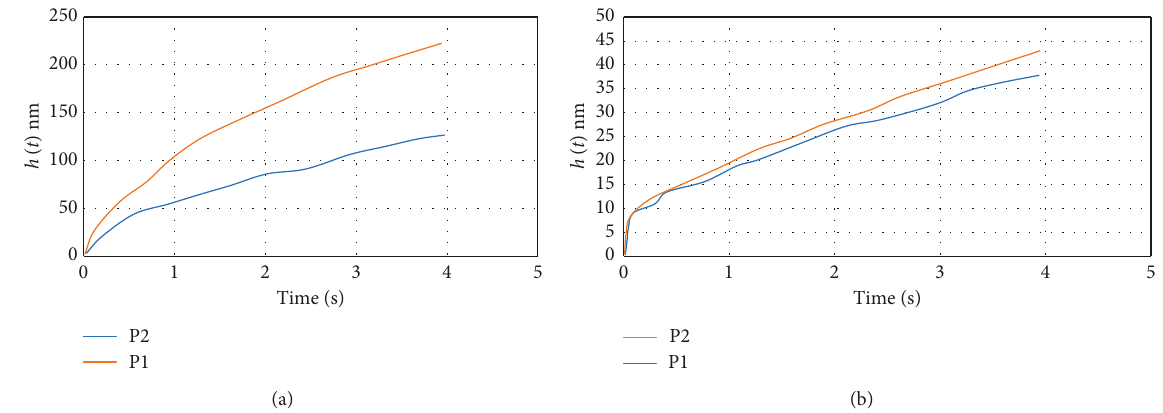
Figure 26: Deformation over time of perpetua (P1) and peri (P2) phases under a creep load of 5 nanonewtons for unaged (a) and aged (b) asphalt samples. The figure is reproduced from Allen [33] (under the creative commons attribution license/public domain). 17.6nm